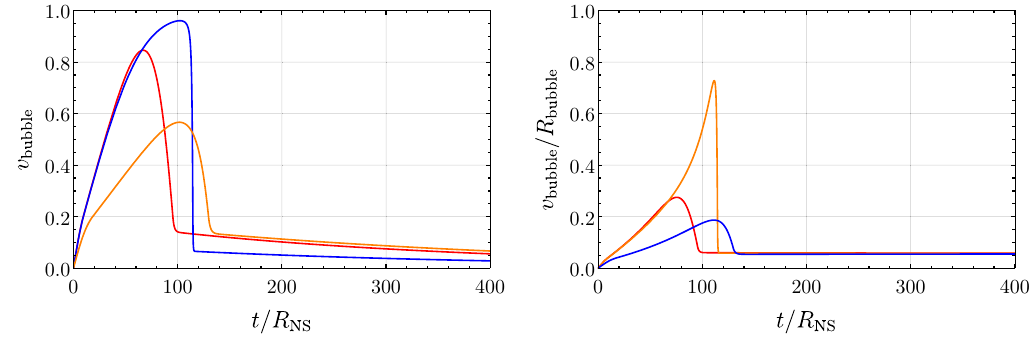
Figure 4 . The evolution of a contracting bubble with different size of energy differences between the two vacua ∆ V . The blue, red and orange lines correspond to cases where ∆ V R max /T = 1 / 2 , 0 , 1 / 2 , respectively. The bubbles in these plots have a R max = 100 R NS when ∆ V = 0. The {− } left figure shows how the bubble velocity evolves as a function of time with ( δm/m ) 1 / 2 = 0 . 2. The right figure highlights the late time evolution where v/R (arbitrary unit) approaches a